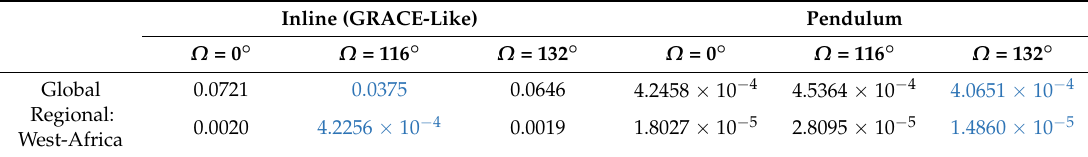
Table 10. Error RMS in terms of geoid height for global and regional (West-Africa) 6-day recovery up to L max = MCNR of the scenario (b) inline and Pendulum formations. The smallest values in global and regional cases for each inline and Pendulum formation are written in blue.